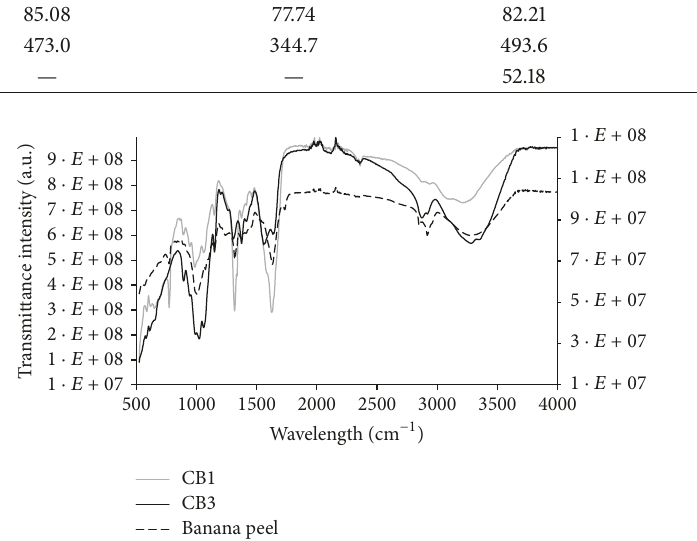
Table 1: Thermal properties of raw materials and membranes: melting temperature and enthalpy of fusion of chitosan, unripe banana peel powder, and membranes obtained by Differential Scanning Calorimetry. Crystallinity degree ( 𝑋𝑐 ) of membranes calculated by (1). Sample/property